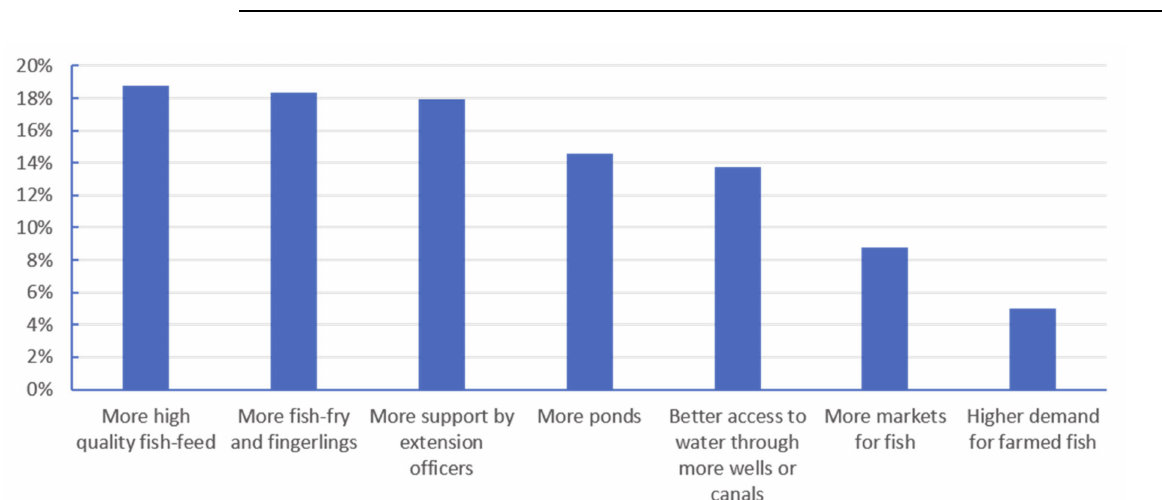
Figure 9. The relative importance of factors for expanding fish pond farming as ranked by 16 regional fisheries officers in